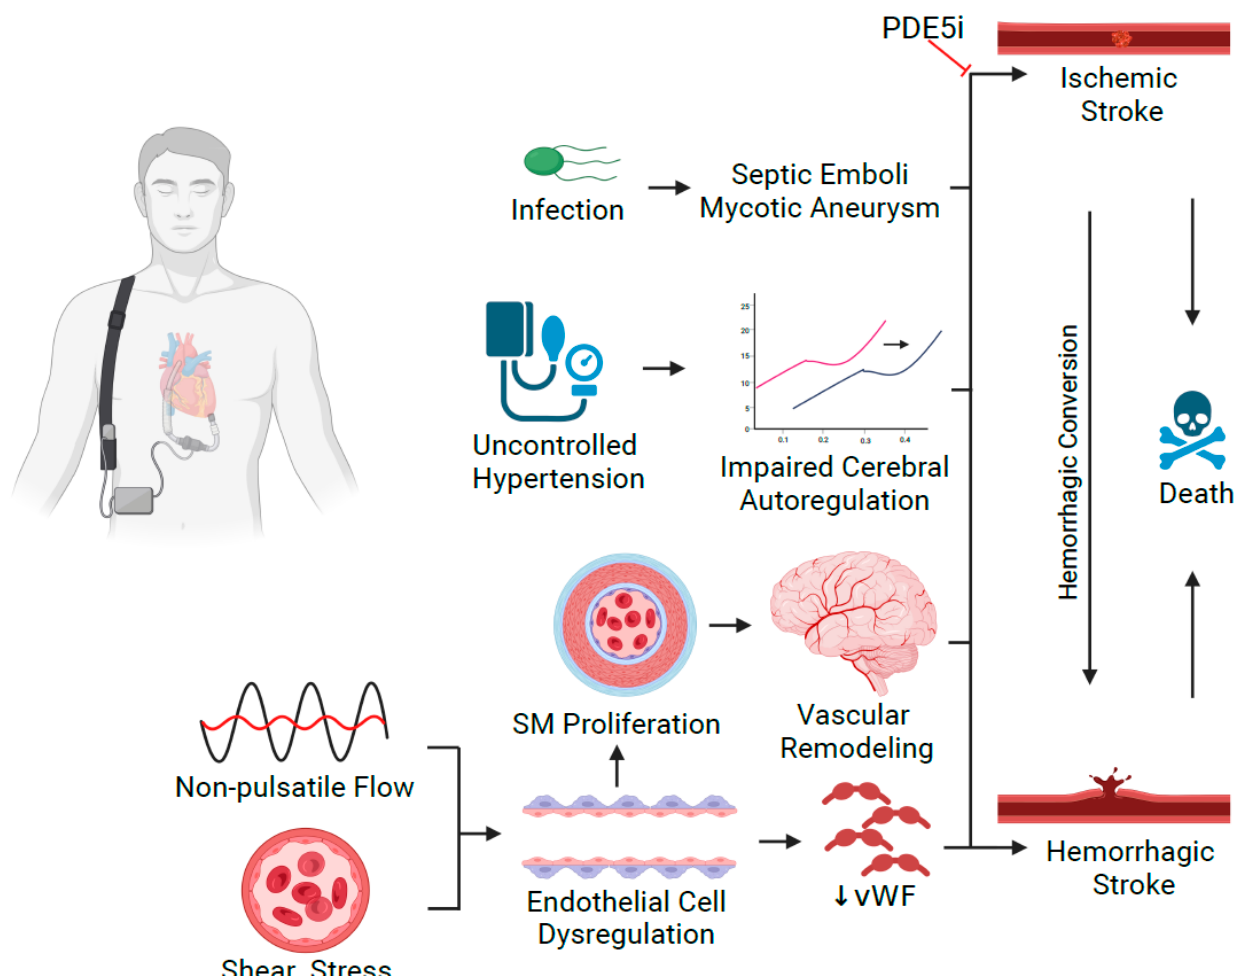
Figure 1. Pathophysiology of stroke in patients supported with CF-LVAD. Continuous flow and shear stress are the main contributors to the development of cerebrovascular pathology, while infection and hypertension are important risk factors. PDE5i: phosphodiesterase 5 inhibitors; SM: smooth muscle; VWF: von Willebrand Factor.